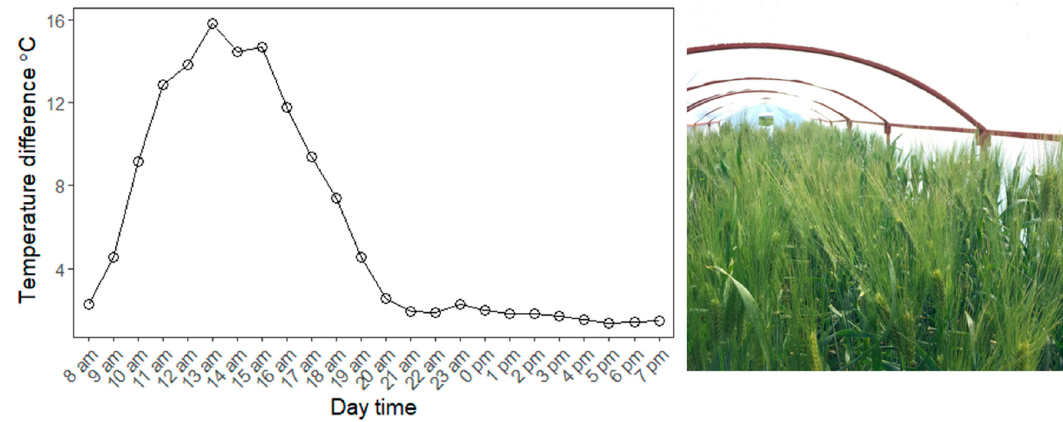
Figure 1. Mean temperature di ff erence of 18 days over two seasons between the plastic tunnel-mediated heat stress and normal field conditions between 8 a.m. and 8 p.m., and a picture of the plastic tunnel at 9 a.m.